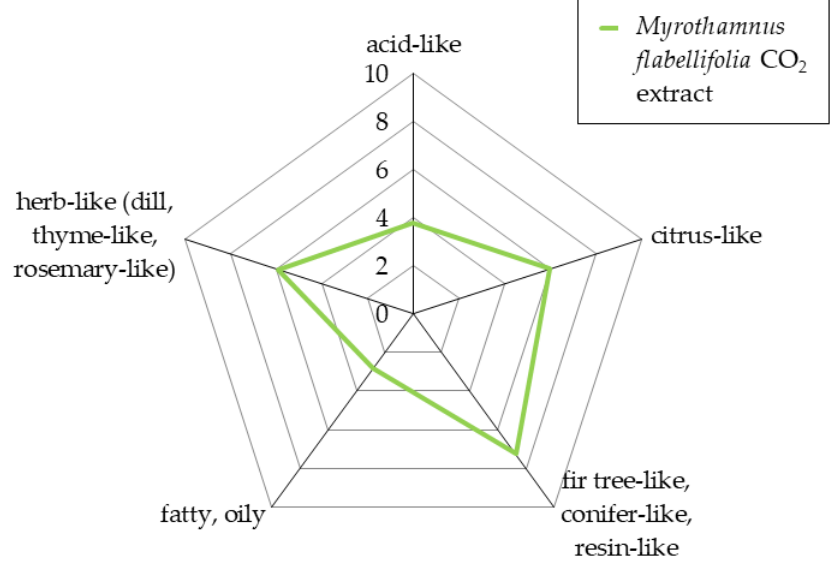
Figure 2. Conventional aroma profile of Myrothamnus flabellifolia extract evaluated by 12 trained testers.